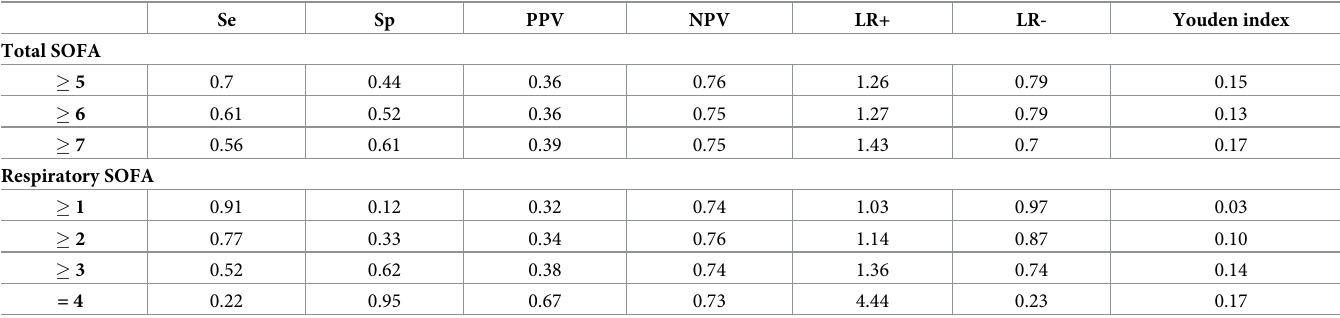
Table 5. Performances of total SOFA and respiratory SOFA for the prediction of mortality in patients with VA-LRTI.